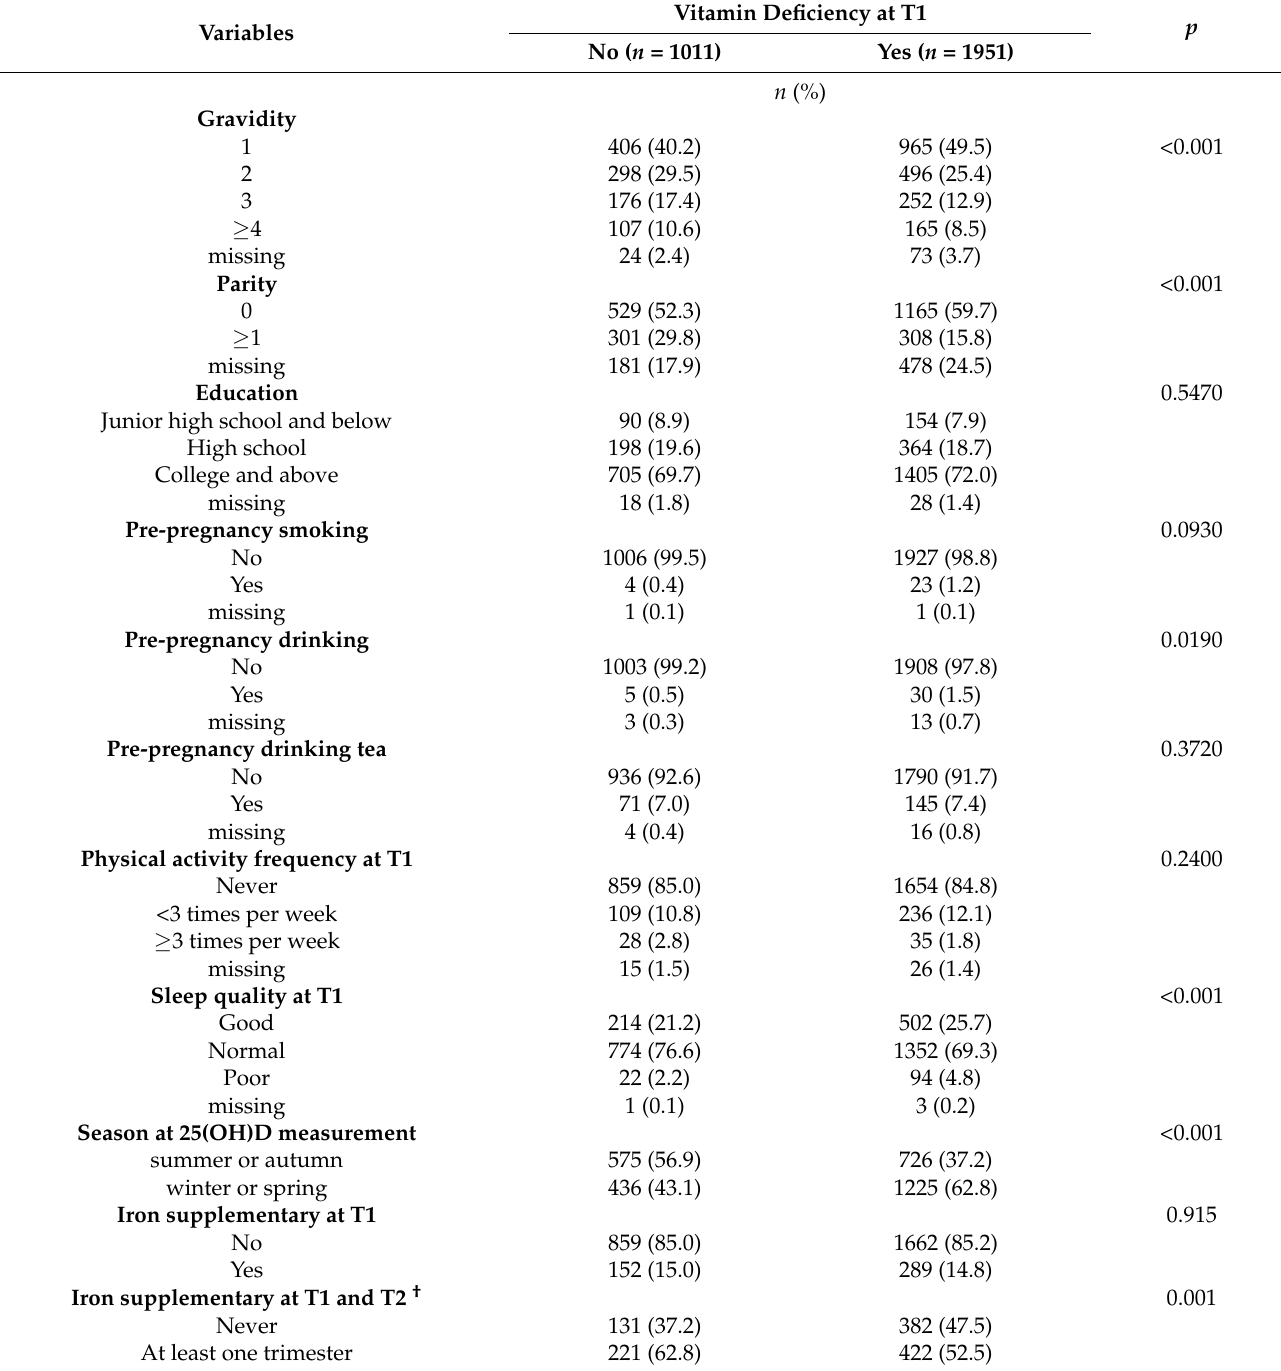
Table 1. The comparisons of characteristics between pregnant women with and without VD deficiency at